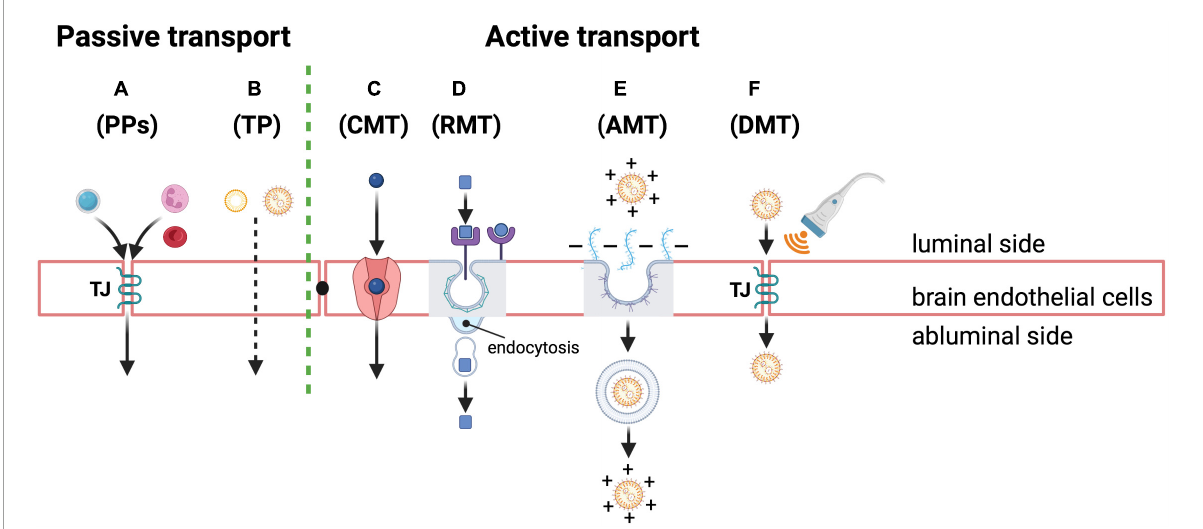
FIGURE3 Passive and active transport mechanisms across the BBB as possible routes of NP entry and drug delivery into the brain. Passive transport through brain endothelial cells: (A) paracellular pathways (PPs) for passive diffusion of small water-soluble and polar substances (e.g., a small hydrophilic molecule in light blue) or cells (e.g., neutrophil and red blood cells depicted in pink and red in the cartoon, respectively) through the TJ structure (TJ in the cartoon); transcellular pathway (TP) (B) for passive diffusion of small non-polar and lipophilic molecules (e.g., micelles or lipid NPs in the cartoon). Active transport through brain endothelial cells: (C) carrier-mediated transcytosis (CMT) of small molecules through specific transporters (depicted in pink in the cartoon); (D) receptor-mediated transcytosis (RMT) of diverse molecules (e.g., neuropeptides, hormones and drug-loaded NPs depicted with square and round shapes in the cartoon) thanks to specific receptors (depicted in violet in the cartoon) that are highly expressed on the luminal side of endothelial cells; this pathway also represents the most exploited strategy to deliver drugs into the brain using polymeric NPs whose cell surface receptor can be captured by clathrin-coated vesicles (depicted in gray outline in the cartoon) that, following their internalization, release the final cargo into the abluminal side of the endothelium; adsorptive mediated transcytosis (AMT) of molecules (E) via electrostatic interactions between positive charged macromolecules, such as neuropeptides, drugs or drug-loaded NPs functionalized with cationic proteins/peptides (depicted in orange in the cartoon), and the negatively charged endothelial cell surface owing to anionic proteoglycans (depicted in light blue in the cartoon); after the invagination of the plasma membrane containing the extracellular molecules, the endocytic mechanism mainly relies on caveolae (depicted in gray and violet in the cartoon) for their transport and release; finally, a disruptive mediated transport (DMT) (F) also of NPs (orange) may occur through transient opening of TJ complexes between endothelial cells induced by different artificial methods and approaches, such as brain-targeted transcranial focused ultrasound (transducer depicted in gray and waves in orange in the cartoon) for local drug delivery. Created with